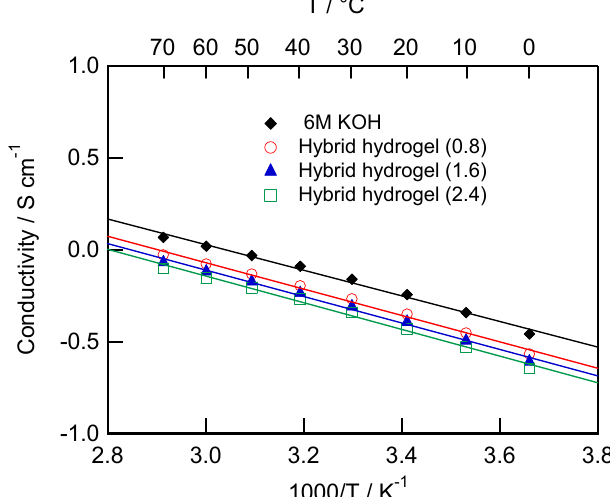
Figure 3. Arrhenius plots of 6 M KOH solution and three hybrid hydrogel electrolytes.